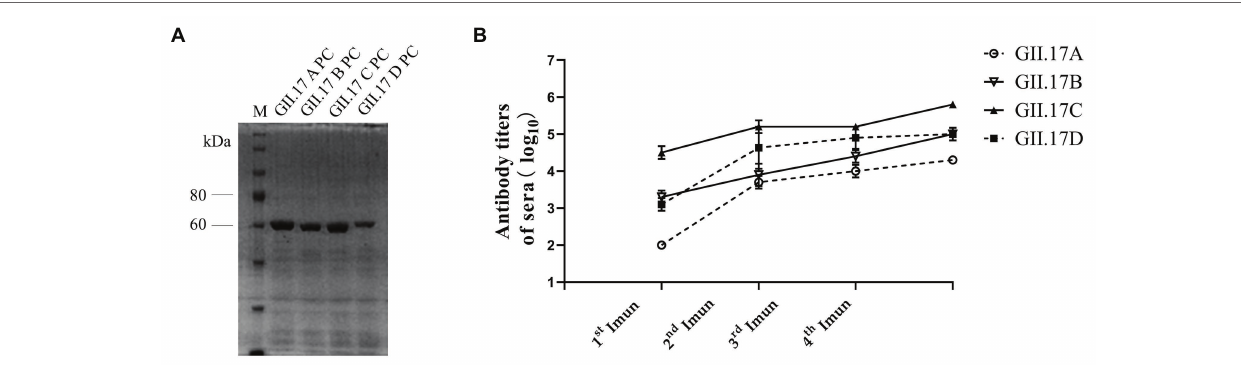
FIGURE 2 | (A) SDS-PAGE analysis of capsid P protein of NoV GII.17 A, GII,17 B, GII.17C, and GII.17 D. The gel was stained with Brilliant Blue (G-250). The M lane contains protein standards. (B) Titers of NoV GII.17 sera antibodies. Sera samples were collected from mice immunized with GII.17 A, GII.17 B, GII.17 C, and GII.17 D fusion protein at weeks 2, 4, 5, and 6. Antibody titers were measured by indirect ELISA using a 1:200 dilution of sera samples, and the results are represented in log10. 1 st Imun, the first immunization; 2 nd Imun, the second immunization; 3 rd Imun, the third immunization; and 4 th Imun, the fourth